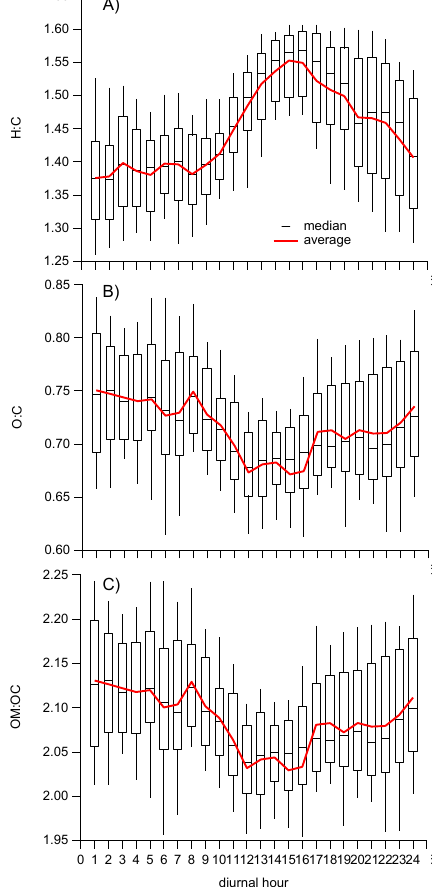
Figure 4. Daily trends of the (a) H:C, (b) O:C and (c) OM:OC ratios. Boxes represent median, 25th and 75th percentile; whiskers indicates 10th and 90th percentile. Time is local (UTC +